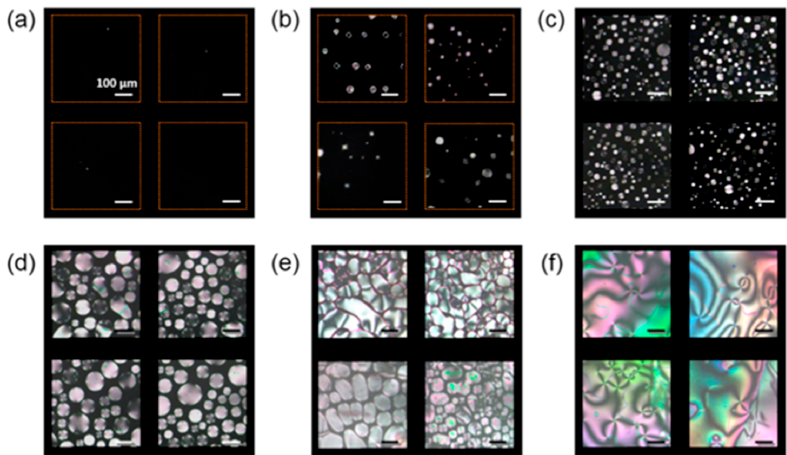
Figure 10. Polarized optical microscopic images of 4 ′ -pentyl-4-biphenylcarbonitrile (5CB) doped with 0.01 wt % NiNSs (nickel nanospheres) in LC cells with substrates assembled with thrombin and the functionalized Au NPs. Thrombin is at concentrations of ( a ) 0.0, ( b ) 0.1, ( c ) 1, ( d ) 10, ( e ) 50, and ( f ) 100 nM. The scale bars in all panels are 100 µm. Here the GNP is attached with immobilized antithrombin aptamer on GPTMS film [(3-glycidoxypropyl)-trimethoxysilane which is an epoxy-group-rich compound], then the nickel nanoparticles doped 5CB NLC is introduced into the sample cell. Reproduced with permission from Ref. [70]. (American Chemical Society).